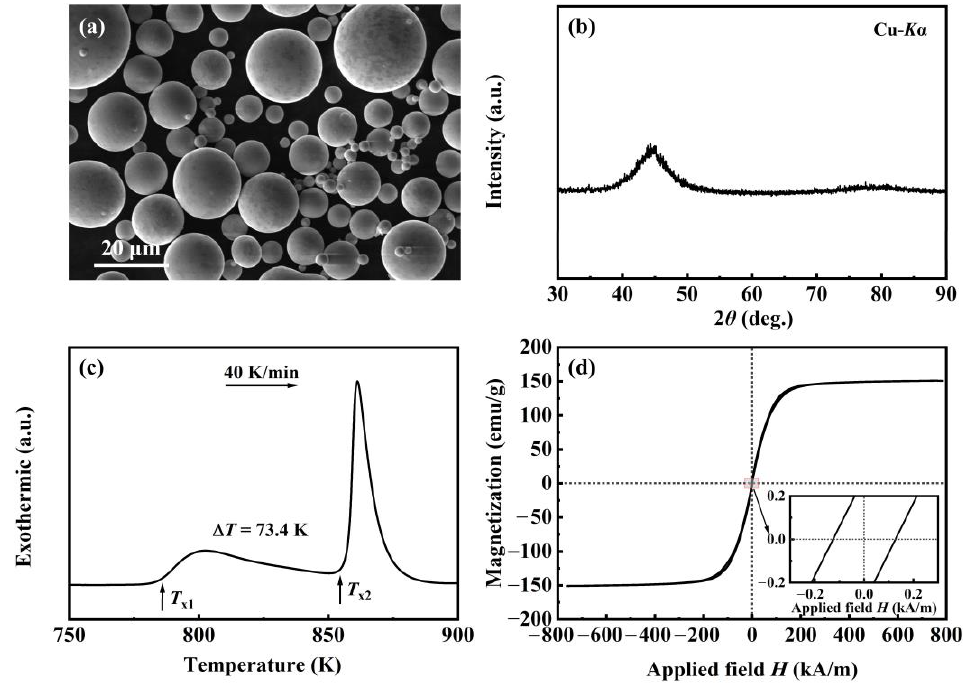
Figure 1. ( a ) SEM image, ( b ) XRD pattern, ( c ) DSC curve, and ( d ) hysteresis loop of gas-atomized Fe 74.75 Si 8 B 10 P 3 C 2 Nb 1.5 Cu 0.75